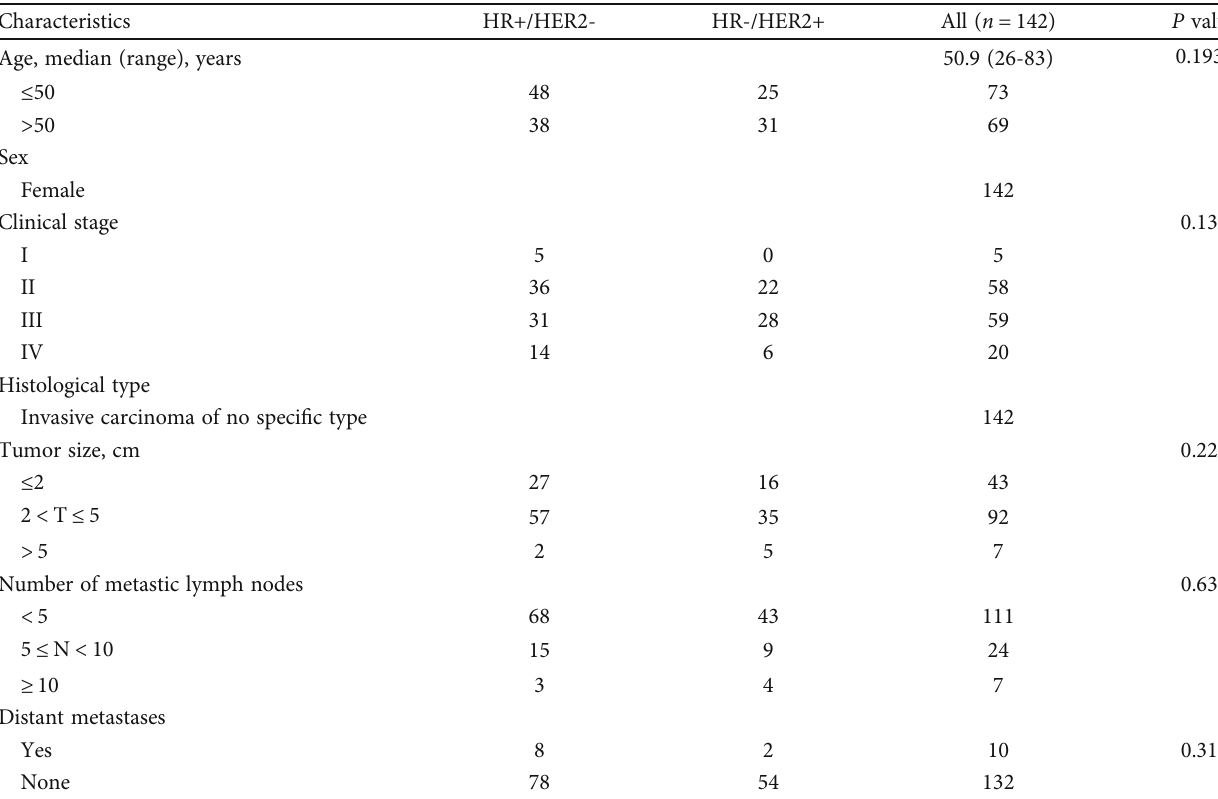
Table 1: Patient